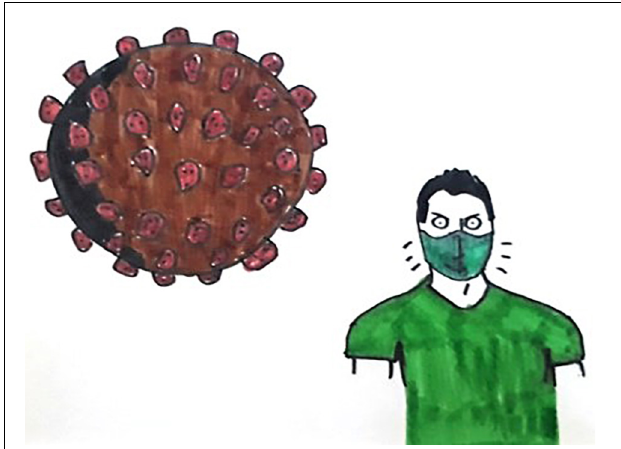
FIGURE 4 | A 6-year-old girl’s inadequate drawing representing SARS-CoV-2 as a monster “with big hands because he reaches everything and eyeglasses because he sees everything.”